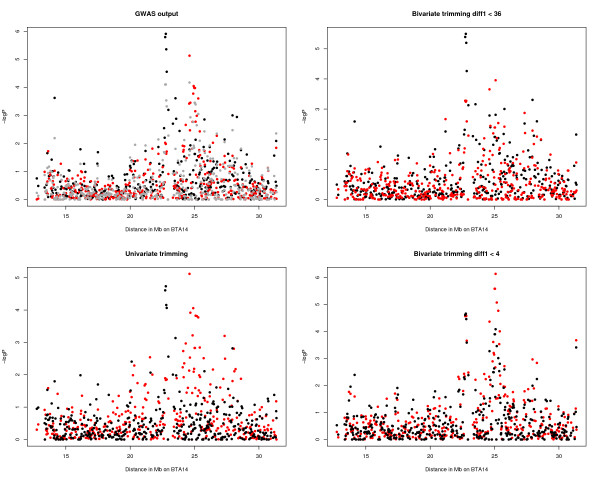
Evidence for QTLs on BTA14 under different kinds and amounts of data trimming. Manhattan plots of SNP associations to CHILLP8 (black) and P8FAT (red) plotted against distance along part of chromosome BTA14 in Mb. The four panels show the original GWAS data, which also includes P8MEAN (dark grey), the univariate trimmed data excluding the top and bottom 5% of values, the bivariate trimmed data with the threshold set at diff1 < 36, and the bivariate trimmed data with the threshold set at diff1 < 4.